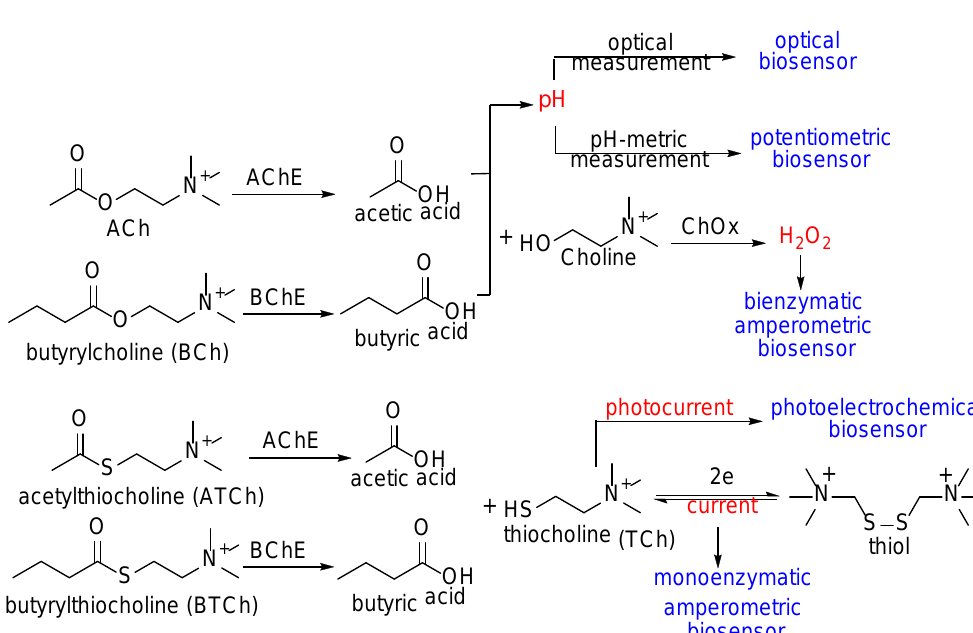
Figure 4. Principles of various types of biosensors.